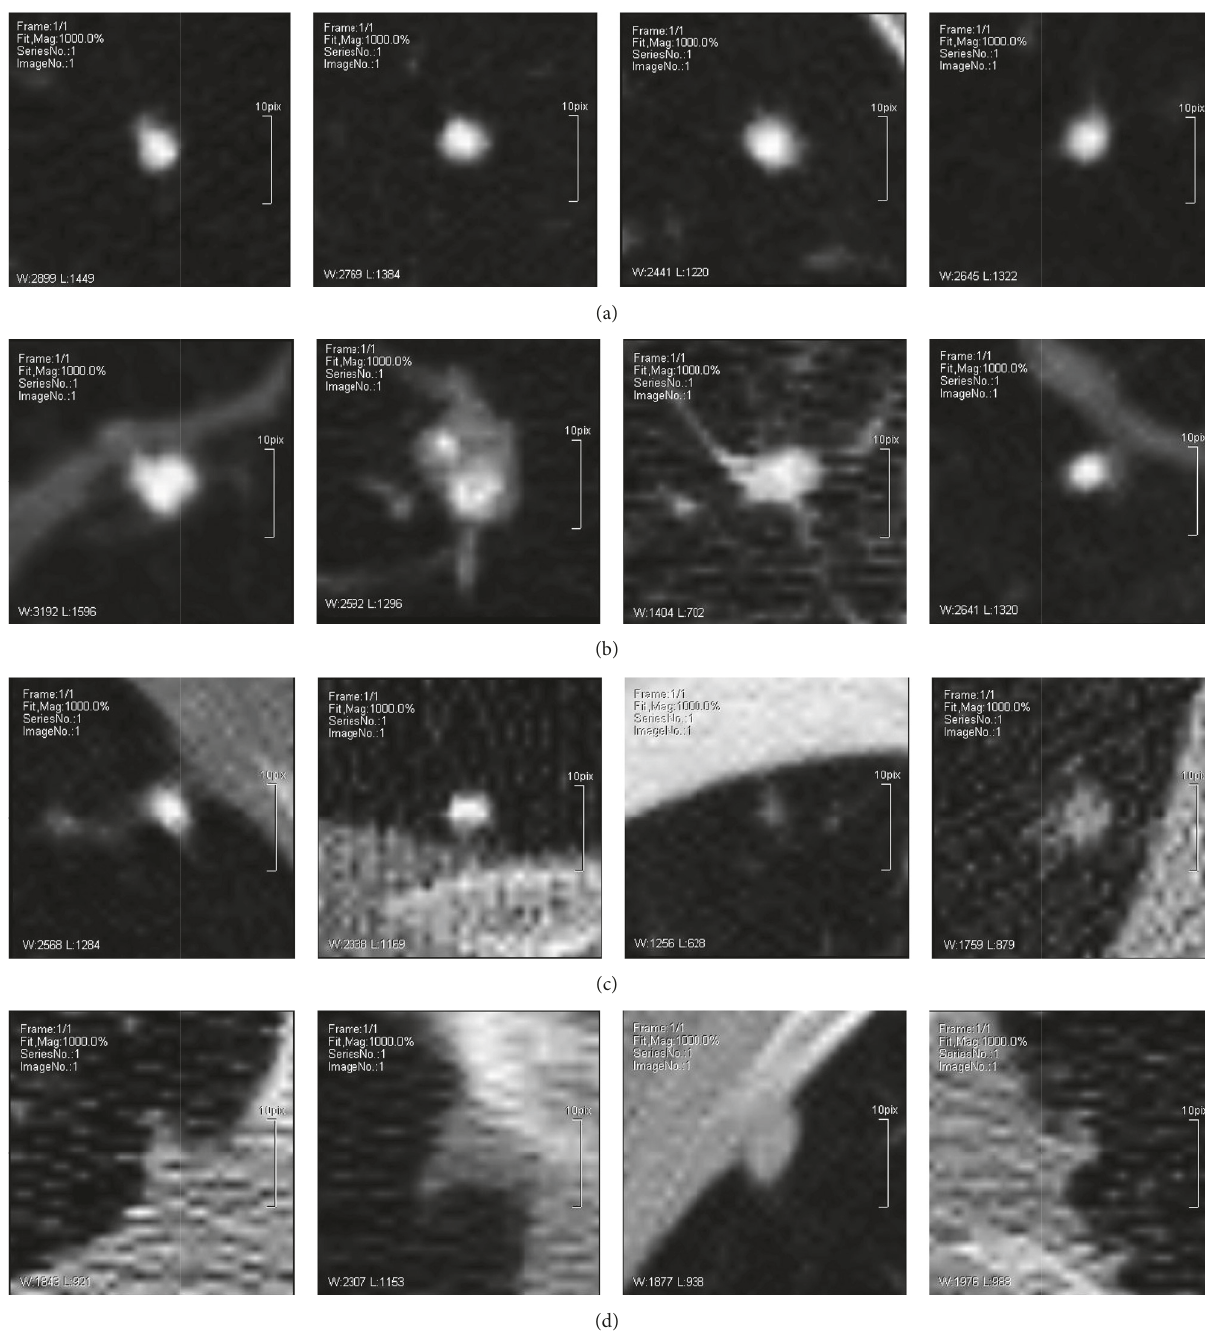
Figure 1: Demonstration of four types lung nodule image samples (cropped from images in